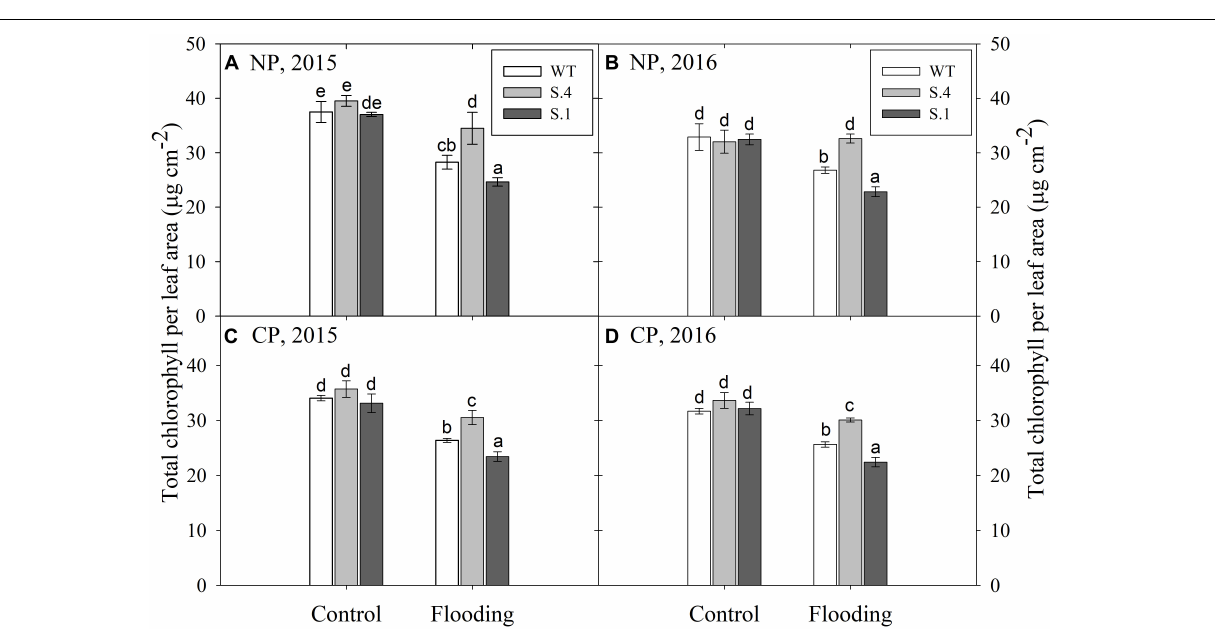
FIGURE 4 | Total chlorophyll content detected on adult expanded leaves at the end of flooding experiments (28th) in plant grown under NP (A,B) and CP (C,D) , for 2 years consecutive tests. Histograms represent the average of five biological replication and the bars ± S.D. Different letters within the same year indicate statistical significance for P <